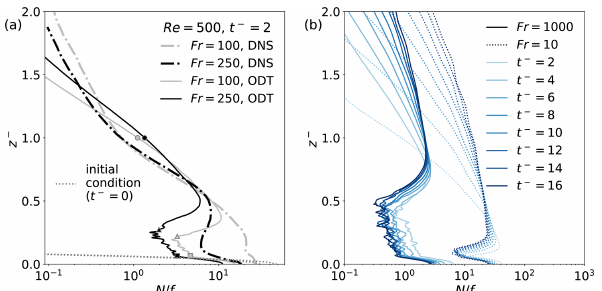
Figure 12. Vertical profiles of the normalized buoyancy frequency N/f . (a) Short-time simulation with comparison to reference DNS results at t − = 2 for I015 and W006 with Re = 500 at Fr = 100 and 250, respectively. Corresponding reference DNS are from An- sorge and Mellado (2014) with a different Ri B due to differences in the ODT and DNS velocity initial condition that manifest them- selves by a difference in the turbulent boundary layer thickness δ ∗ , 0 (see Table 3). (b) ODT prediction of the long-time evolution of the buoyancy frequency for weak and strong stratification cases W001 and S158 shown in Figs. 5 and 6, respectively. “Wiggles” are due to finite sample variability. Note that the horizontal axis is scaled differently in panels (a) and (b)